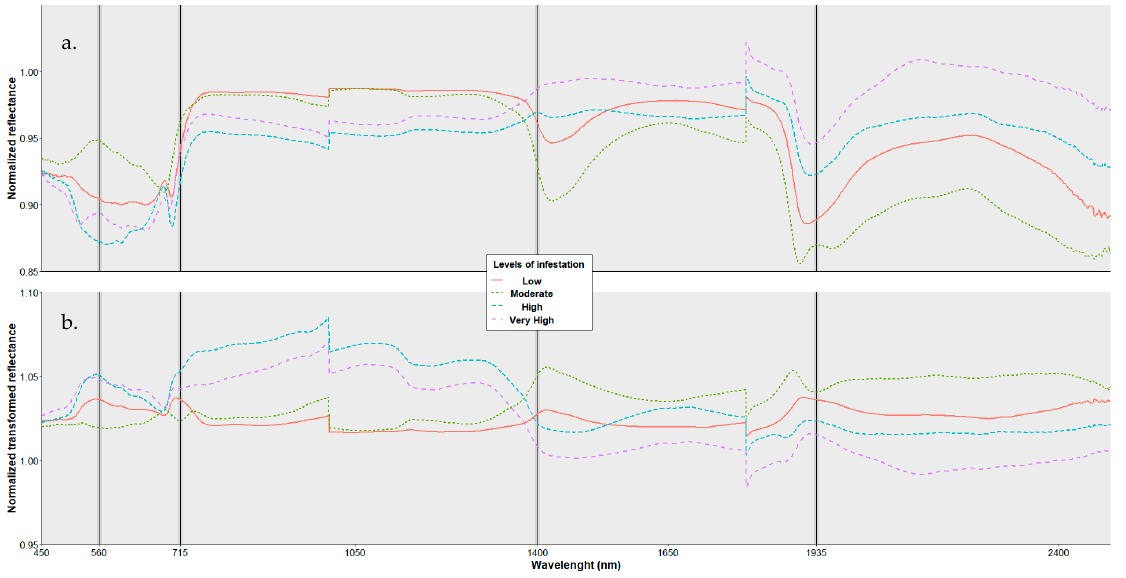
Figure 6. Characteristic spectral traits associated with infestation levels after normalization of reflectance values ( a ) and transformed values ( b ). Black vertical lines indicate the four wavelengths selected as predictor variables for the classification models. Table 5. Classification model overall accuracy (%) as a performance indicator.